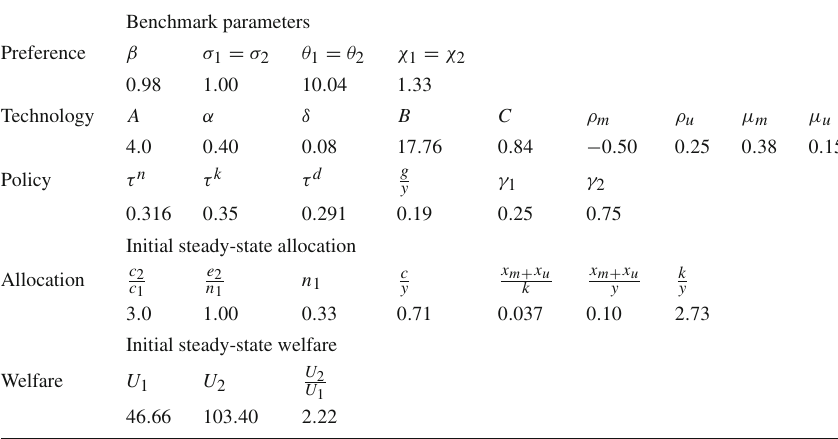
Table 1 Parameter values and initial steady-state allocation and welfare Benchmark